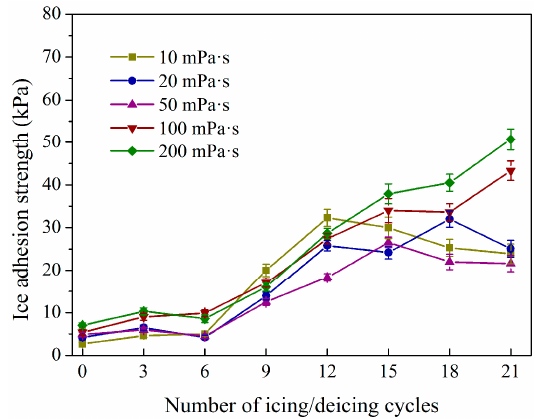
Figure7. VariationintheiceadhesionstrengthoftheSLIPSfilledwithdi ff erentviscosities(10–200mPa · s) Figure 7. Variation in the ice adhesion strength of the SLIPS filled with different viscosities (10–200 mPa·s) of silicone oil after icing/de-icing cycles. of silicone oil after icing / de-icing cycles.